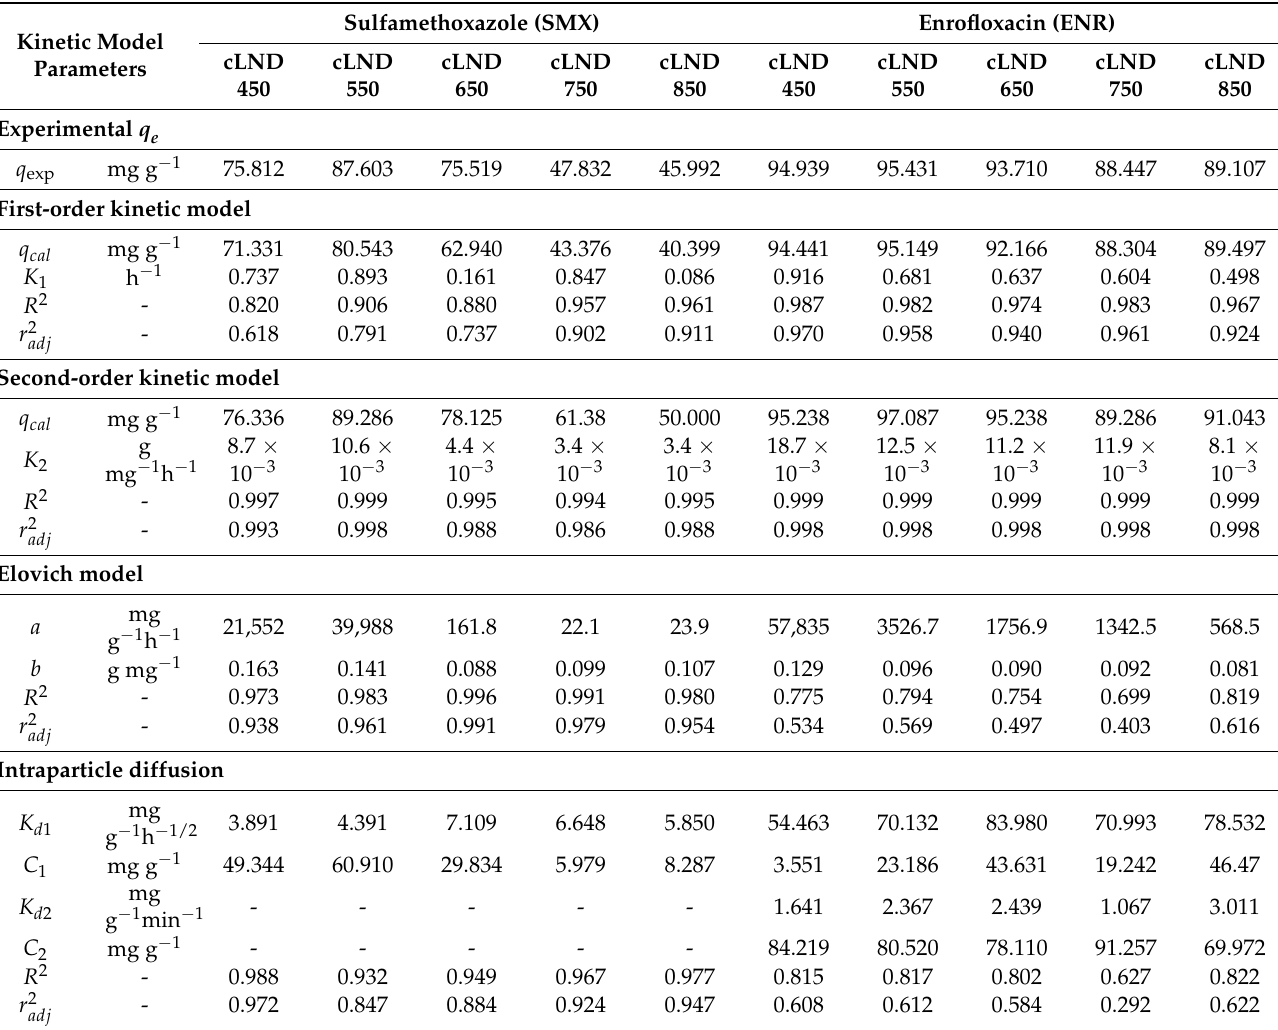
Table 1. Kinetic parameters for SMX and ENR adsorption onto varying types of